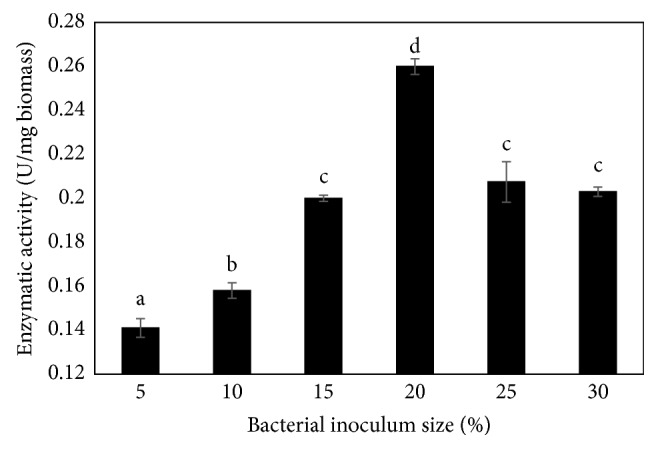
The effect of bacterial inoculum size on glucose isomerase production. In this study, we determined the optimal bacterial inoculum size is 20%. Addition of bacteria (5–20%) in induction medium resulted an increase of enzyme activity, but bacterial inoculum size also exhibited the inhibitory effect at the higher levels (25–30%). a, b, c, and d indicate the significant difference between groups.